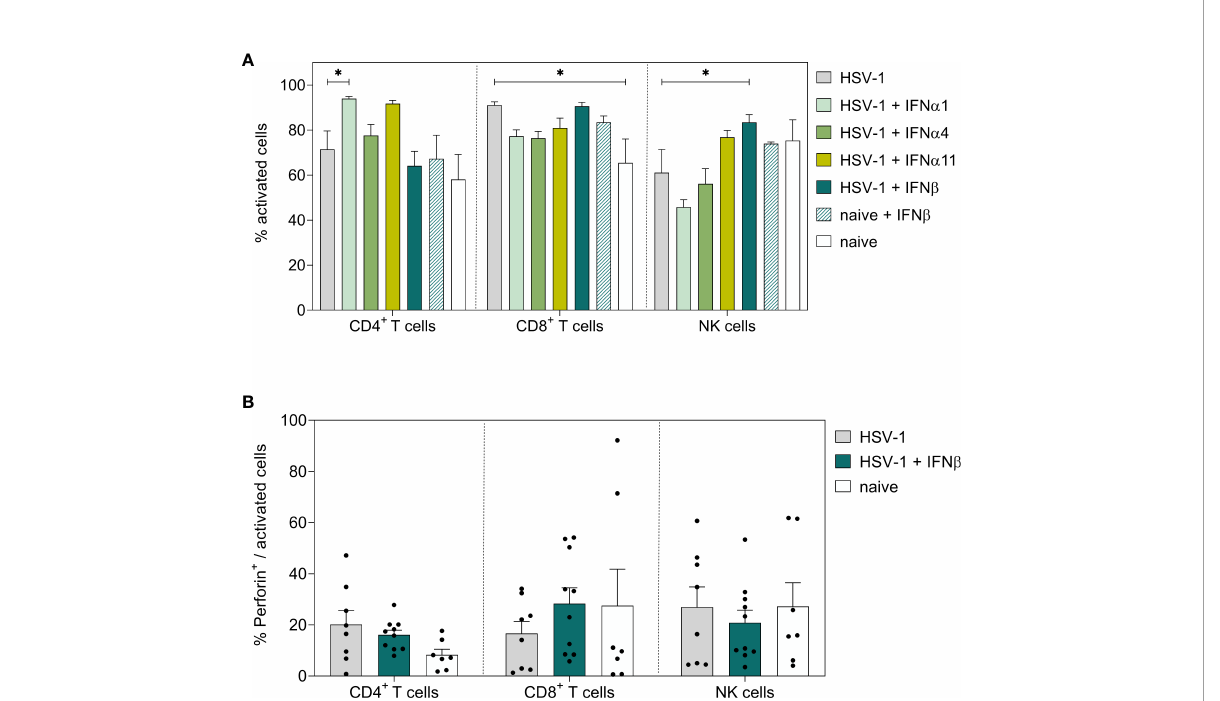
FIGURE 3 Local immune responses in the vaginal tract on day 8 post HSV-1 infection. Female C57BL/6 mice were infected with 1×10 7 TCID 50 of HSV-1 F for eight days or left uninfected (naive control). Mice were treated with 8000 U of murine IFN a 1, IFN a 4, IFN a 11, and IFN b for six consecutive days starting on day 2 p.i. or left untreated (HSV-1). On day 8 p.i. , vaginal lymphocytes were isolated from dissected vaginal tracts. For fl ow cytometric analysis, isolated cells were subsequently stained for respective cell surface and intracellular markers. (A) Frequencies of activated CD4 + T cells, CD8 + T cells, and NK cells and (B) percentage of respective Perforin-expressing, activated cell populations are shown. Data points represent individual mice; bars indicate the mean values ± SEM for each group (HSV-1 n = 8 mice, HSV-1 + IFN a 1 n = 10 mice, HSV-1 + IFN a 4 n = 10 mice, HSV-1 + IFN a 11 n = 5 mice HSV-1 + IFN b n = 10 mice, naive + IFN b n = 4 mice, naive n = 7 mice). Statistical analyses were conducted via 2way ANOVA and Tukey ’ s multiple comparison test. Statistically signi fi cant differences compared to the HSV-1 group are depicted by * P <